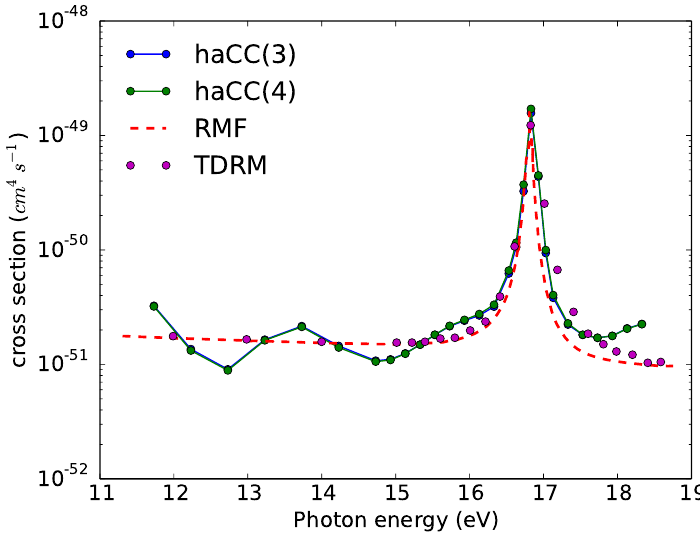
Figure 2. Two photon ionization cross-sections of Neon as a function of photon energy. The RMF and the TDRM results are from [12]. haCC(3): Ionic basis consists of only 1 s 2 2 s 2 2 p 5 states. haCC(4): Ionic basis consists of both 1 s 2 2 s 2 2 p 5 states and 1 s 2 2 s 2 p 6 state. The results from haCC(3) and haCC(4) are